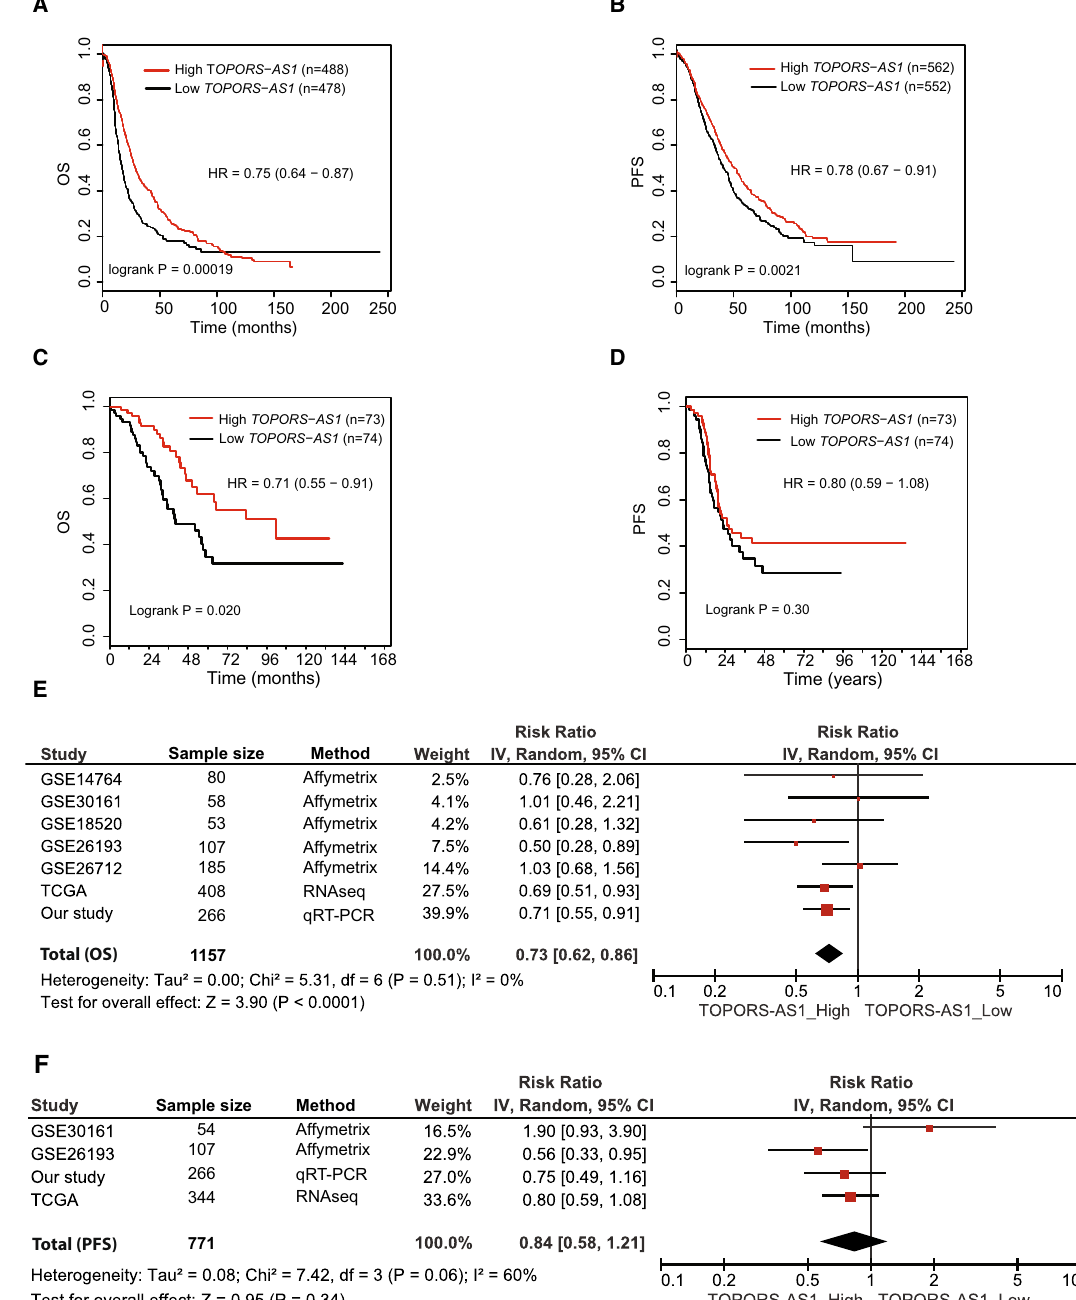
Figure 1. Kaplan–Meier survival curves in ovarian cancer patients with high and low TOPORS-AS1 expression. ( A ) Kaplan–Meier overall survival curves by high (upper tertile) and low (lower tertile) expression of TOPORS-AS1 from online Kaplan–Meier Plotter. ( B ) Kaplan–Meier progression-free survival curves by high (upper tertile) and low (lower tertile) expression of TOPORS-AS1 from online Kaplan–Meier Plotter. ( C ) Kaplan–Meier overall survival curves by high (upper tertile) and low (lower tertile) expression of TOPORS-AS1 from our study. ( D ) Kaplan–Meier progression-free survival curves by high (upper tertile) and low (lower tertile) expression of TOPORS-AS1 from our study. ( E ) Forest plots for associations between TOPORS-AS1 expression and overall survival. ( F ) Forest plots for associations between TOPORS-AS1 expression and progression-free